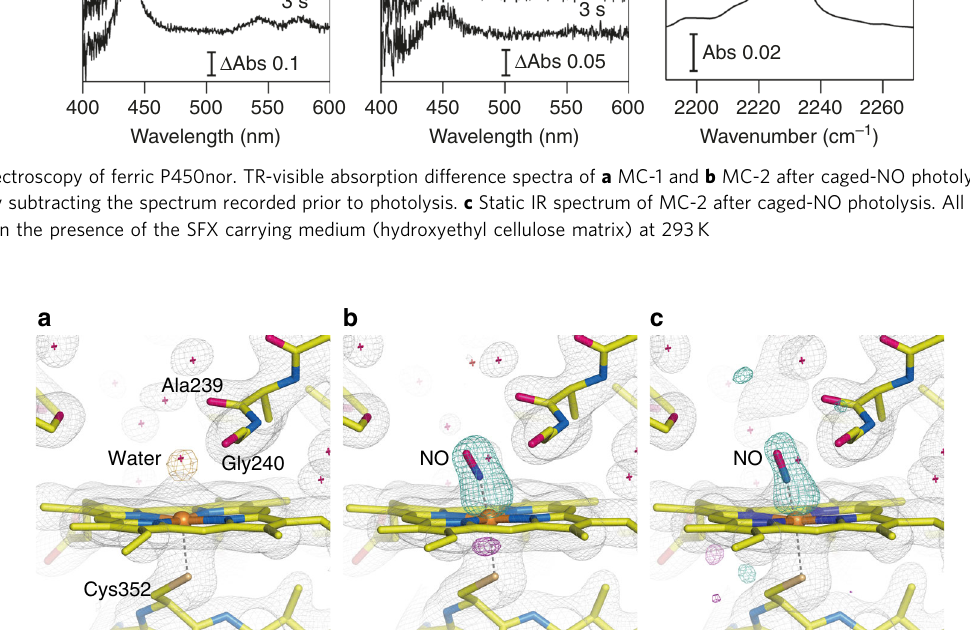
Fig. 4 SFX structures of P450nor. a Resting-state structure. b , c Transient structures at 20 ms after caged-NO photolysis in the b absence and c presence of NADH. The 2 F o − F c maps are shown in gray and contoured at 1.2 σ . The F o − F c map is shown in orange and contoured at 4.0 σ in a , whereas the F o ( “ Light ” ) − F “ Dark2 ” ) difference Fourier maps are shown in turquoise (positive) and magenta (negative) and contoured at 6.5 σ in b and 3.2 σ in c . All data were o ( taken at ambient temperature. In a , the structure using the “ Dark2 ” data of MC-2 is